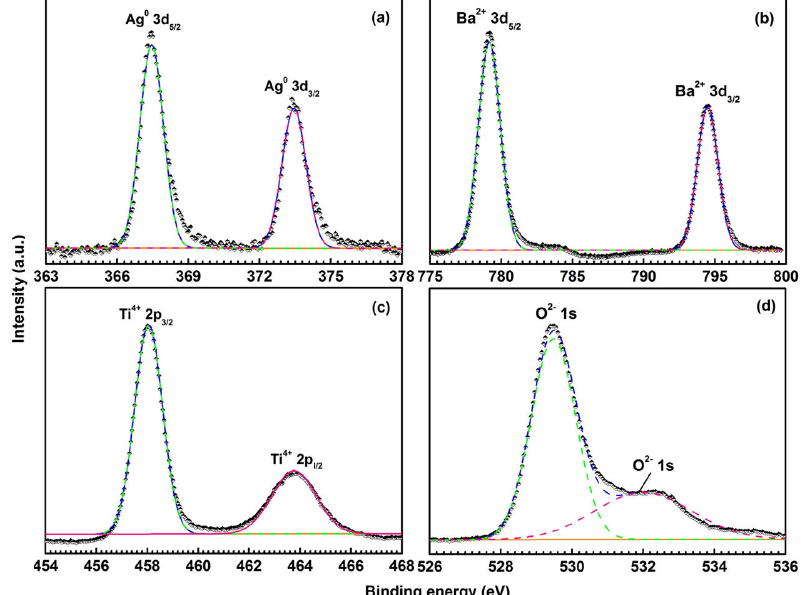
Fig. 4 High-resolution XPS spectra of the Ag 25 /BTO thin film: (a) Ag 3d, (b) Ba 3d, (c) Ti 2p, and (d) O